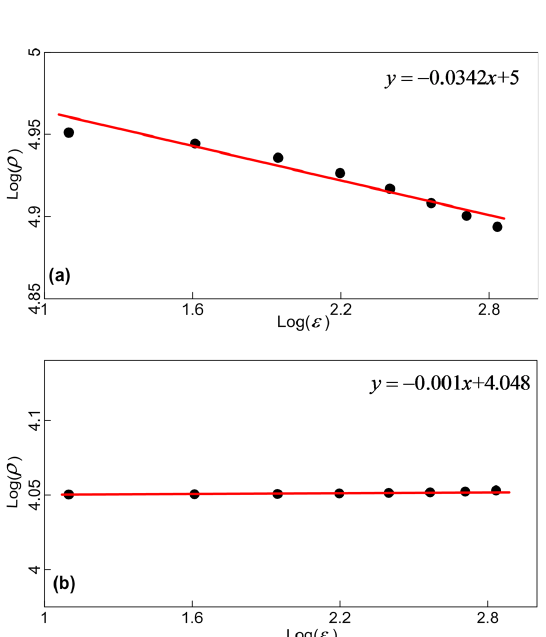
Fig. 3. (a) Log–log (base 10) plot showing the relationship between the average concentration values ρ(ε) and the box size ε centred at sphere 1 with coordinates (x=260m, y=500m) in Fig. 2c. (b) Log–log (base 10) plot showing the relationship between the av- erage concentration values ρ(ε) and the box size ε located in the regional field area with coordinates of (x=900m, y=900m) in Fig.